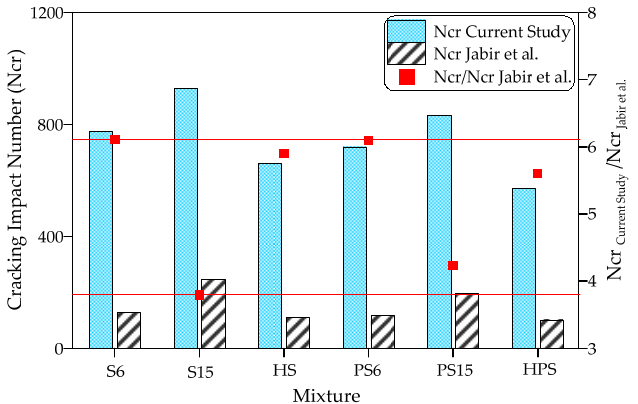
Figure 13. Comparison of Ncr records in the study by Jabir et al. [67] with the Ncr records of the current study.